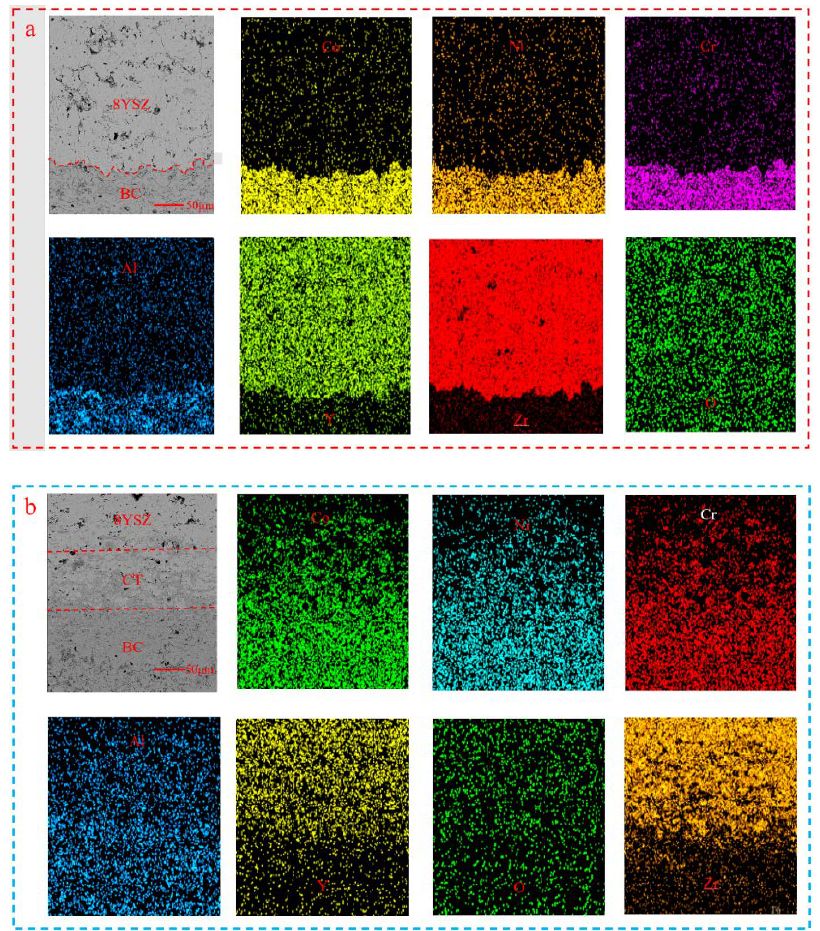
Figure 3. SEM image and element distribution of traditional coating ( a ) and continuous transition coating ( b ).